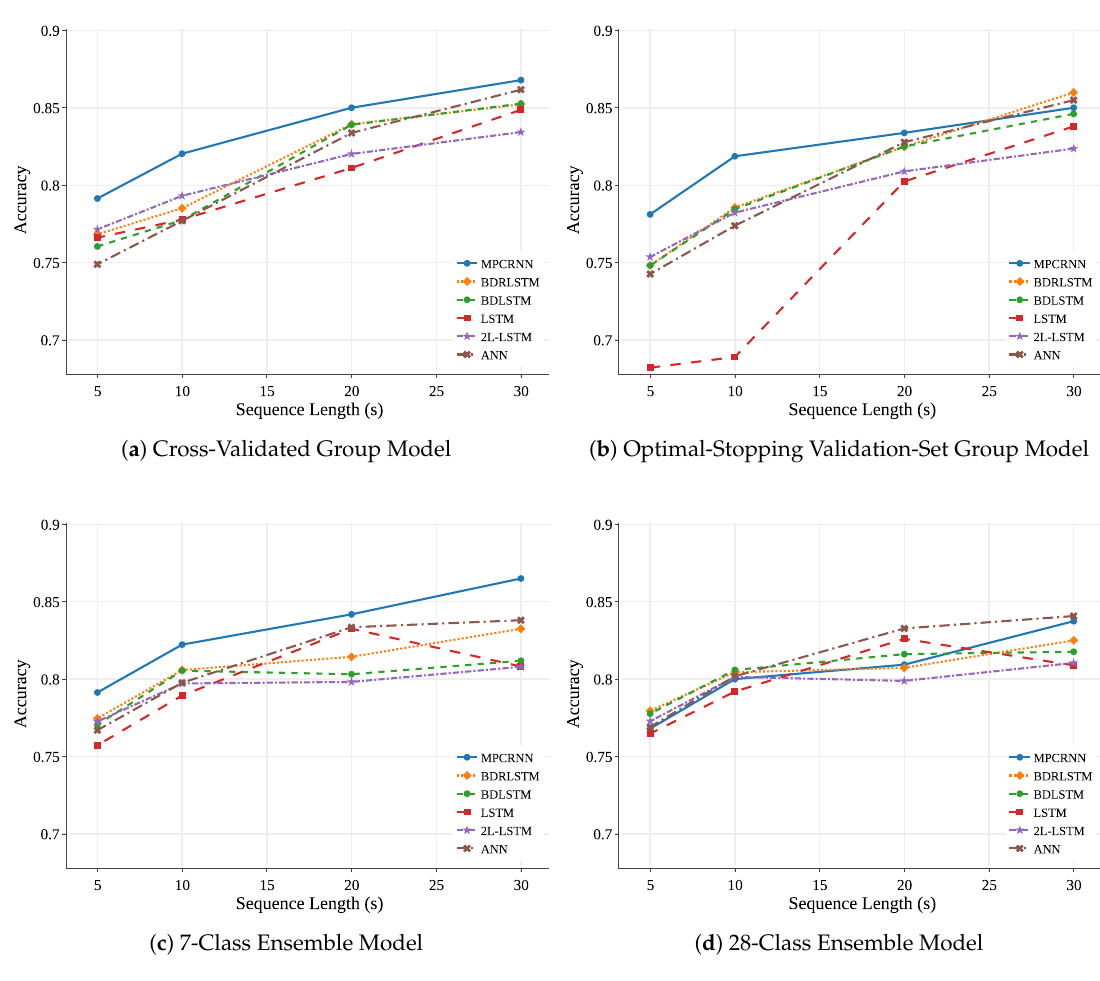
Figure 5. Mean classification accuracy for all participants as a function of sequence length, architecture, and training technique. Mean classification accuracy tends to improve as a function of sequence length for all classifiers and training methods. Error bars are omitted for